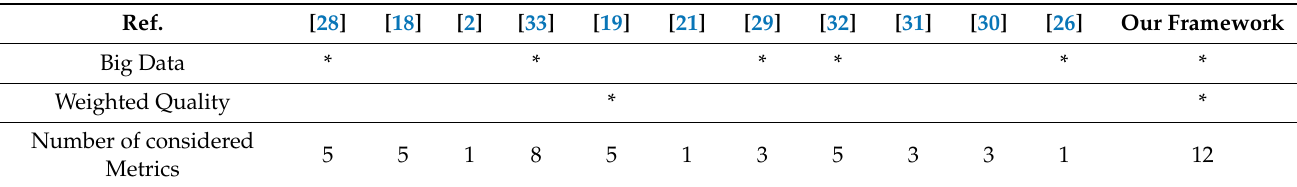
Table 15. Comparative table of precision and big data